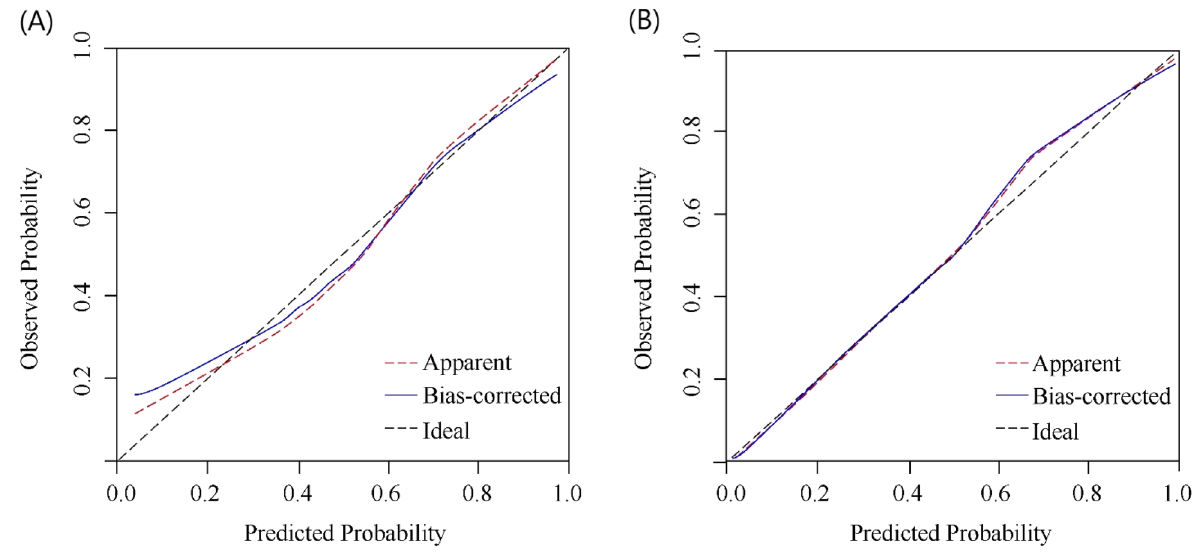
Figure 2. Calibration curves of the nomogram in the training ( A ) and validation ( B ) cohort.